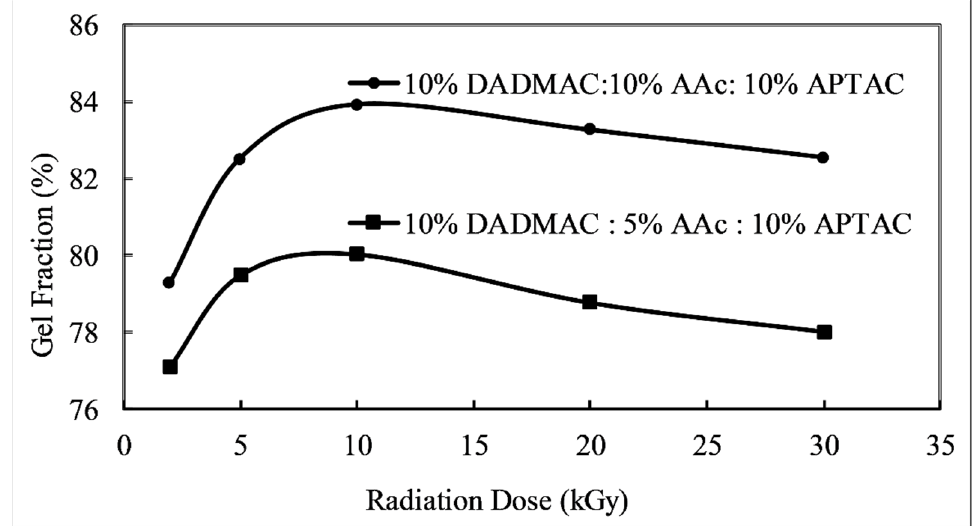
Figure 1. Effect of radiation dose on gel fraction of hydrogel.